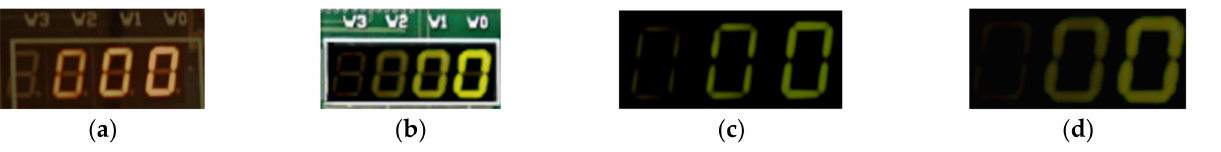
Figure 5. The multiplexed seven-segment LED display: ( a ) MKD-51 photo; ( b ) MKD-51 SIM image; ( c ) normalized MKD-51 photo for analysis; and ( d ) normalized MKD-51 SIM image for analysis.